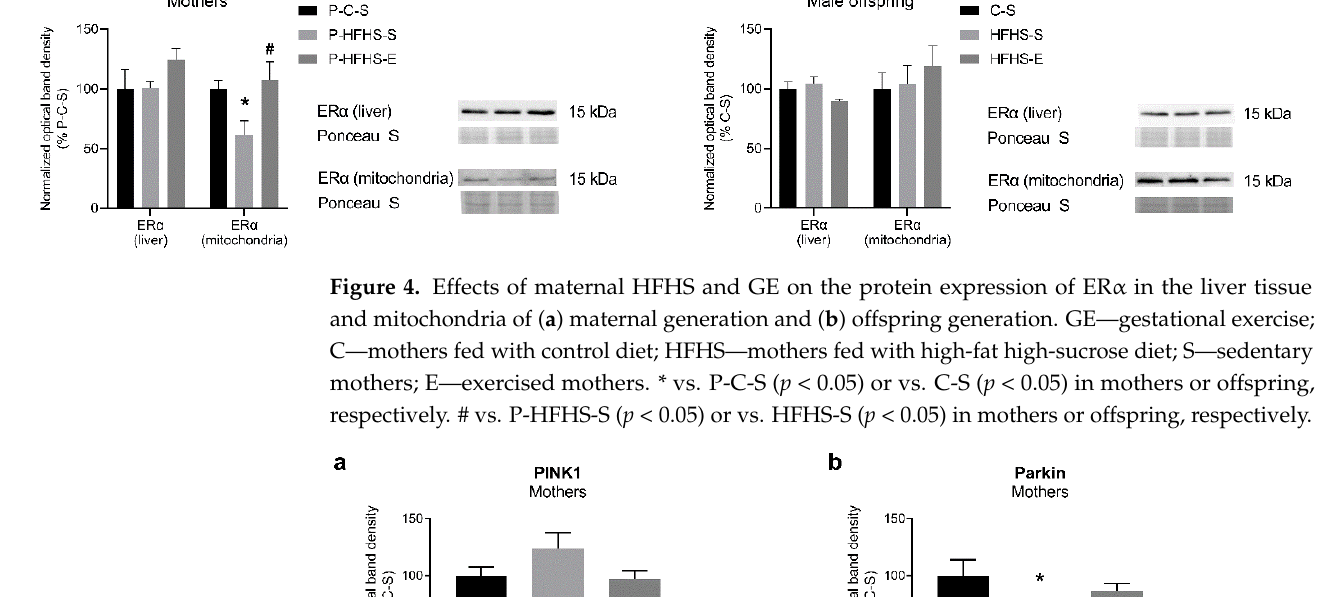
Figure 5. Effects of maternal HFHS and GE on the protein expression of different markers of auto(mito)phagy signalling in liver and liver mitochondria in mothers: ( a ) relative content of PINK1,